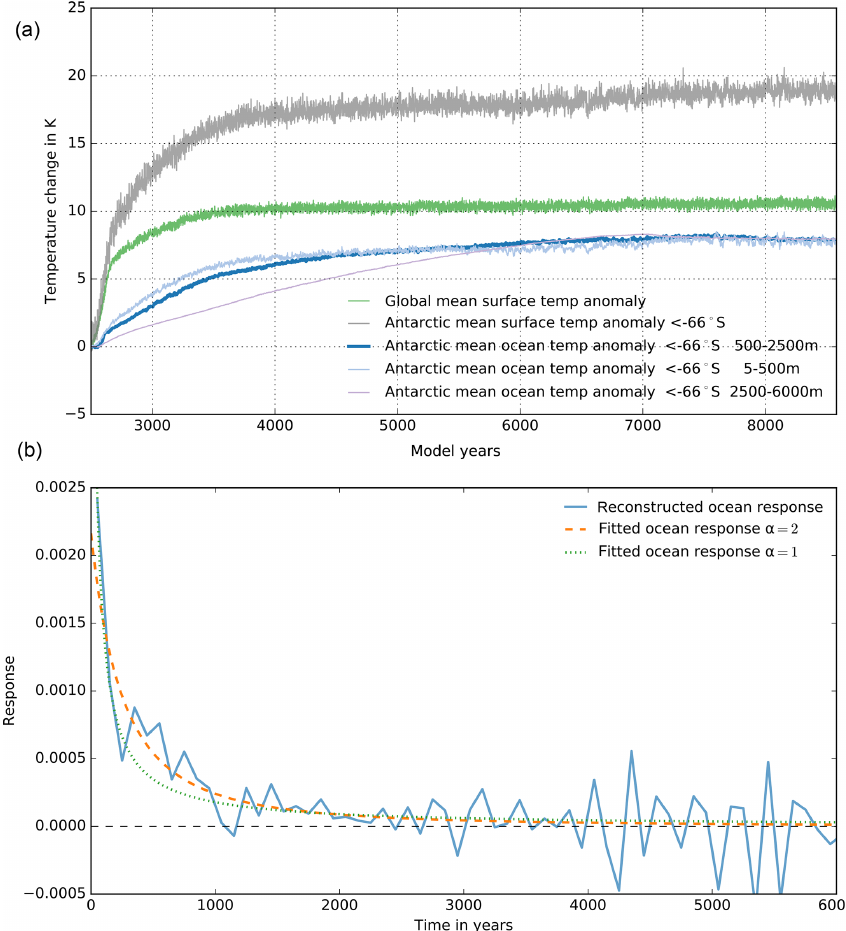
Figure 20. Climate model data and response function analysis – (a) global mean temperature (green); Antarctic mean temperature south of 66 ◦ S (grey); and ocean temperature averaged over upper 500m (light blue), intermediate (500–2500m; blue) and deeper layers (below 2500m; violet) of the MPIOM model coupled to ECHAM5 forced by a CO 2 quadrupling within 140 years (Li et al., 2012). (b) Reconstructed response function R(t) (blue) with fitted function R ∗ (t) (orange dashed) as in Eq. (14). For comparison the fit function with α = 1 (green dotted) is